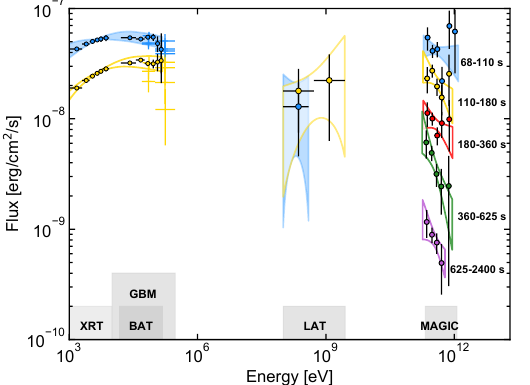
Figure 20. GRB190114C SEDs from soft X-rays to 1TeV in five different time intervals. The contour regions for flux uncertainties are also shown. For MAGIC and LAT the 1 σ error of their best-fit power-law functions are displayed. For Swift data, the 90% confidence contours for the XRT-BAT joint fit is shown. MAGIC spectra are EBL-corrected assuming the model by [183]. From